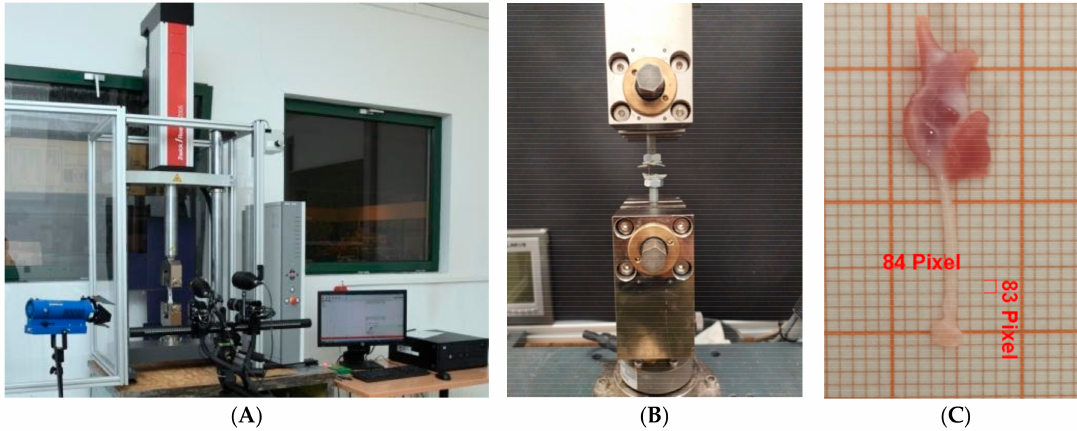
Figure 1. Static tensile test: ( A )—Zwick/ROell EPZ 005 testing machine, ( B )—the specimen clamping, ( C )—a digital specimen parameterization; papillary muscle is at the top and valve part is at the